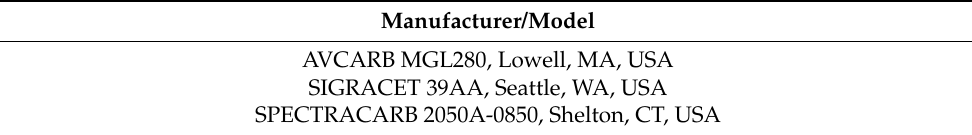
Table 1. Names and models of the three GDL media analyzed.